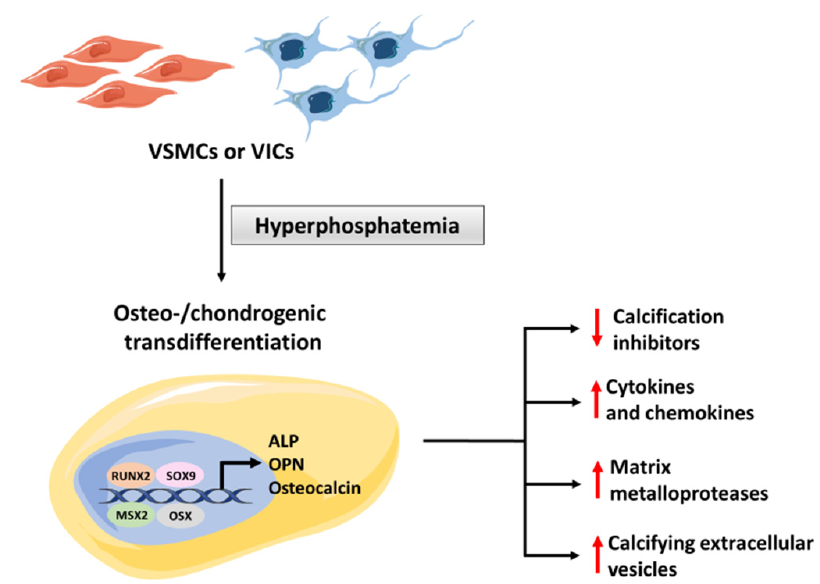
Figure 3. Mechanism of transdifferentiation of vascular smooth muscle cells (VSMCs) or valvular interstitial cells (VICs) into osteoblasts. RUNX2 = Runt-related transcription factor 2; MSX2 = Msh homeobox; OSX = Osterix; OPN = osteopontin; ALP = alkaline phosphatase.